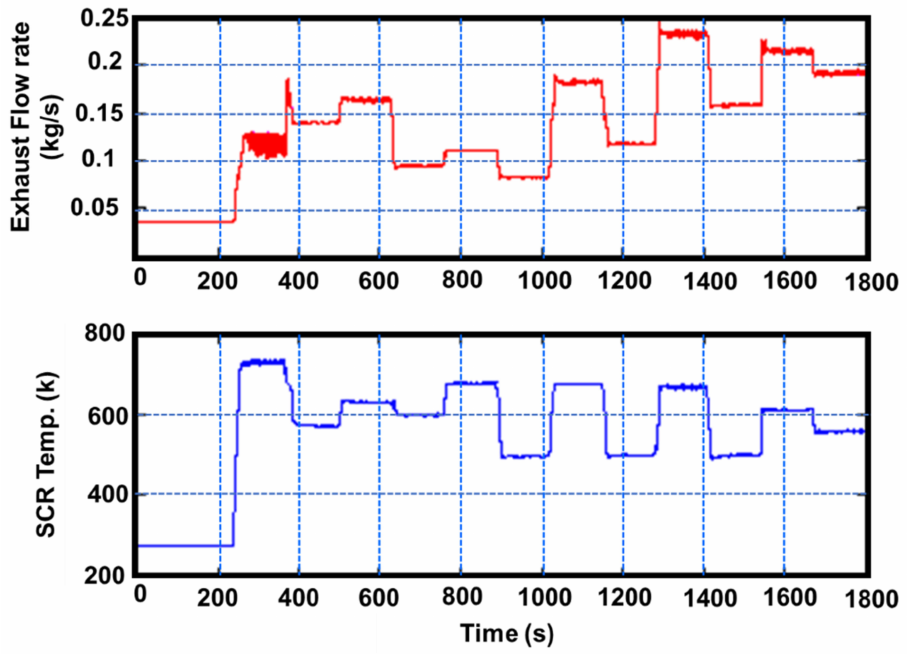
Figure 20. Exhaust flow rate and SCR temperature profile for the ESC test, adapted from Wei et al.